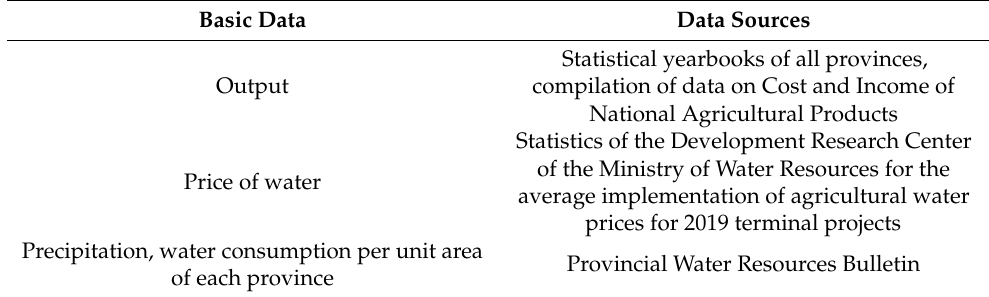
Table 1. Data sources.